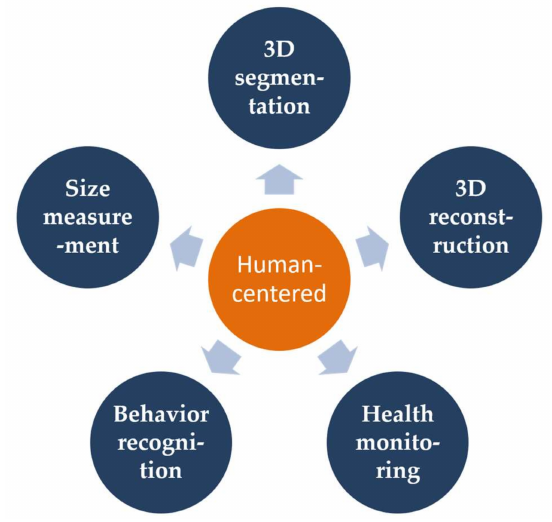
Figure 1. Human-centered applications of depth